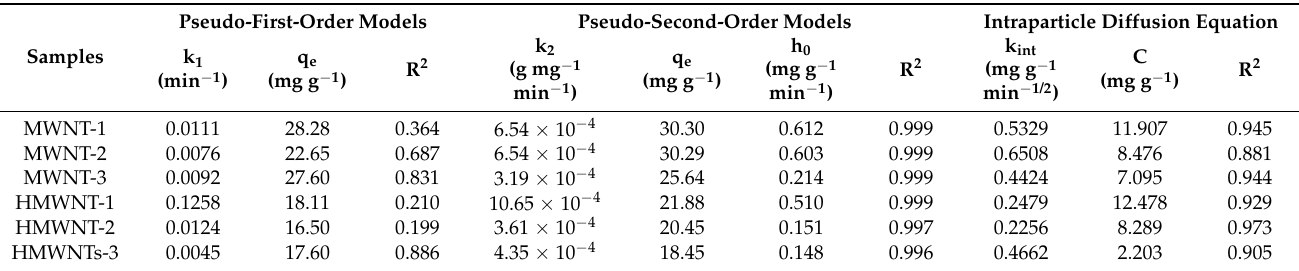
Table 3. Adsorption kinetic parameters of HA on MWNTs and